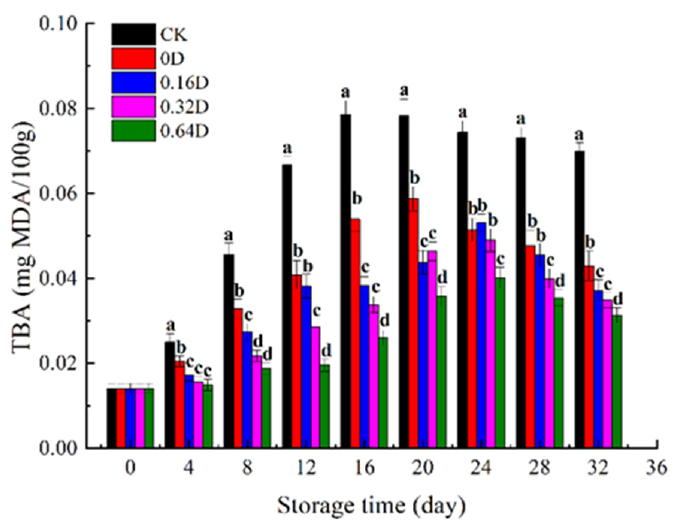
Figure 3. Changes in the TBA of turbots during refrigerated storage. Different superscript letters a–d indicate significant differences ( p < 0.05) .